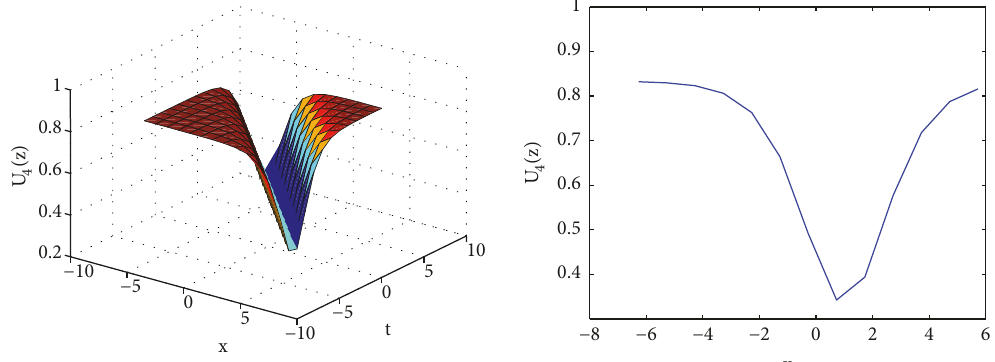
Figure 8: The 3D and 2D surfaces of 𝑈 4 (𝑧) by considering the values 𝑘 = 1 , 𝐿 = 1 , 𝜆 = 1 , 𝛼 = 1 , 𝑦 = 0 , 𝑧 0 = 1 , and 𝑡 = 0 for the 2D graphic.